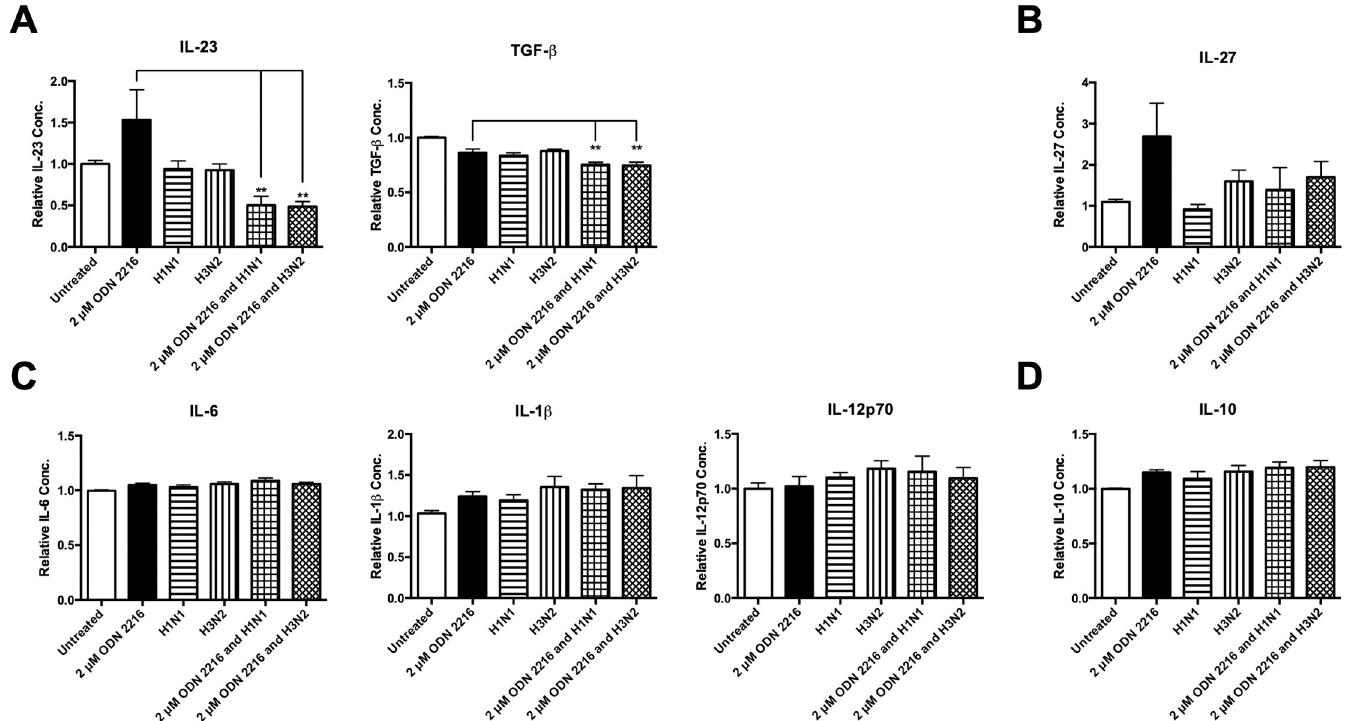
Fig 4. Live IAV specifically targets TLR9 pathway in human monocytes. Levels of (A) IL-23, TGF- β , (B) IL-27, (C) IL-6, IL-1 β , IL-12p70, and (D) IL-10 secreted by CD14 + cells following 24 h treatment with a TLR9 mono-agonist (ODN 2216), live H1N1 or H3N2 alone or in combination with ODN 2216 (or untreated as a control) were determined by ELISA. Each column represents normalised mean cytokine levels + SEM of 3 technical repeats of each treatment in every donor. Each ELISA represents normalised results from multiple donors (n): (A) IL-23 (n = 9), TGF- β (n = 9), (B) IL-27 (n = 9), (C) IL-6 (n = 9), IL-1 β (n = 9), IL-12p70 (n = 5), and (D) IL- 10 (n = 9). Statistical analyses were performed to compare cytokine levels in cells treated with ODN 2216 versus cells exposed to live H1N1 or H3N2 in combination with ODN 2216 by fitting a One-Way ANOVA to the data and using a Sidak test to adjust for multiple testing ( �� p < 0.01).